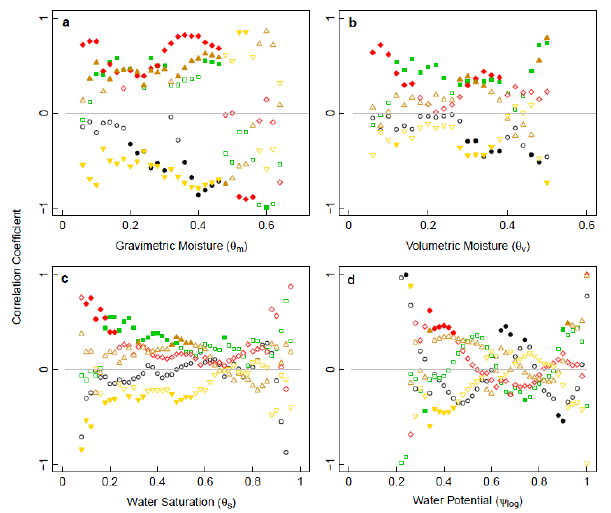
Fig. 2. The respiration response to moisture (PR SR ) correlated with soil properties of mineral soils. Correlation coefficients of PR SR vs. bulk density (black circles), organic carbon (green squares), sand (yellow inverted triangles), silt (brown triangles) and clay (red diamonds) on the y-axis are shown for different levels of soil mois- ture (SM) on the x-axis. Full symbols denote correlations signifi- cant at p < 0 . 05. Units of soil moisture in the x-axis are: g H 2 O gSoil − 1 ( a ), cm 3 H 2 O cm − 3 ( b ), cm 3 H 2 O cm − 3 pore-space ( c ) and [-log 10 | ψ | kPa ]/5+1 ( d ).